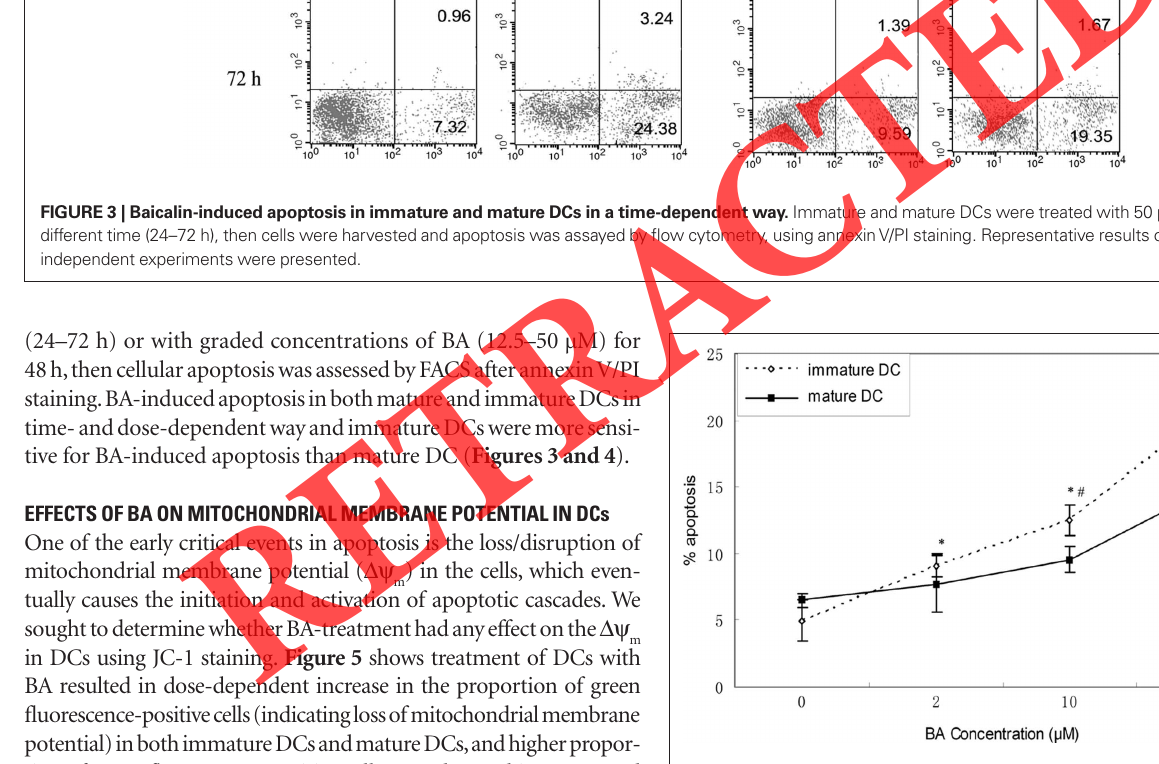
Figure 4 | Baicalin-induced apoptosis in immature and mature DCs in a dose-dependent way. Immature and mature DCs were treated with BA (0–50 μM) for 48 h, then cells were harvested and the percentage of apoptosis was determined by flow cytometry, using annexin V/PI staining. Results were obtained from three independent experiments and presented as mean values ( ± SD). * p < 0.05 vs. 0 control, # p < 0.05 vs. mature DC control by Student’s t